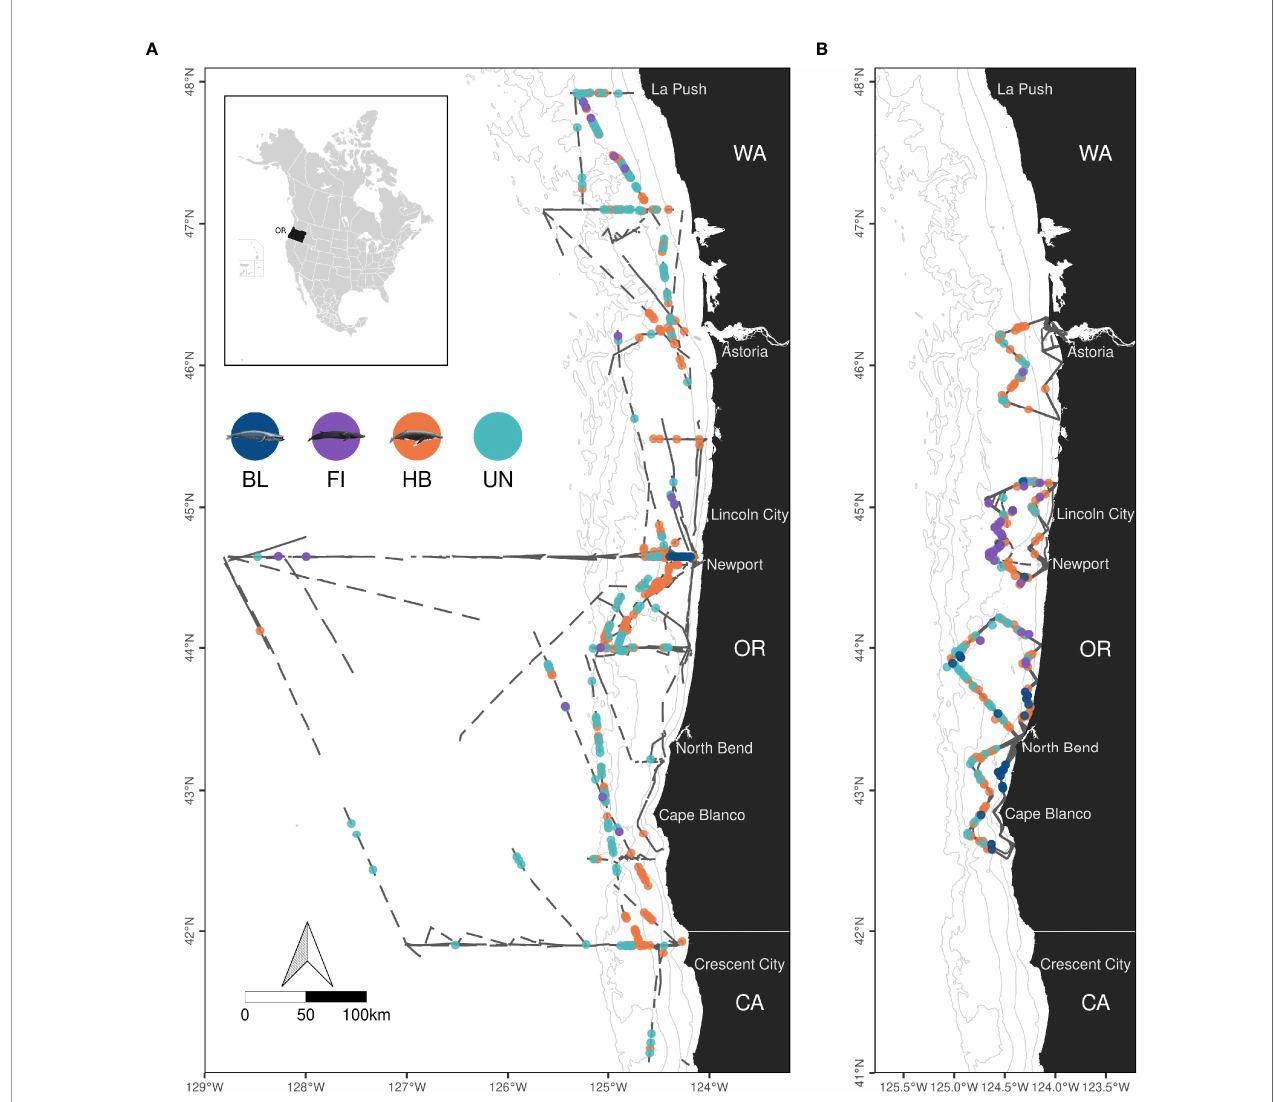
FIGURE 1 | Map of shipboard (A) and helicopter (B) survey effort and observations of rorquals (BL, blue whales; FI, fi n whales; HB, humpback whales; UN, Unidenti fi ed rorquals) from 2016 to 2021 in Oregon waters (OR), USA. Dark grey lines represent surveyed transect lines in Oregon (OR), California (CA) and Washington (WA) states. Land is shown in black. Isobaths (50, 100, 500, 1,000 and 1,500 m deep) are represented with grey lines. Maps are limited to 41°N but shipboard effort extends south to 37°N. Credits for whale illustrations: Fre ́ de ́ rique Lucas and NOAA